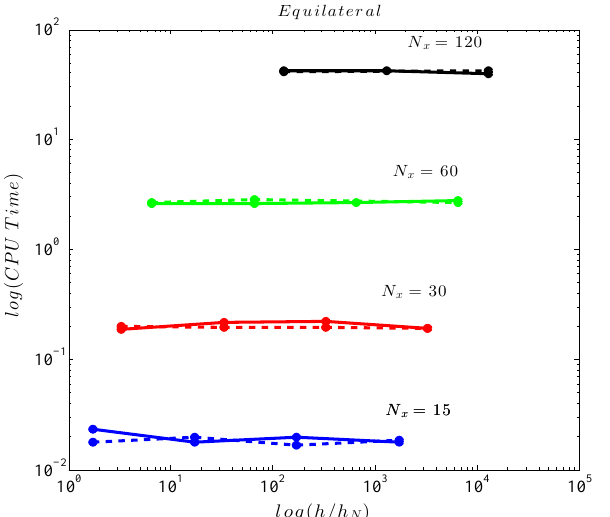
Figure 7. CPU time versus h / h N for GMRES (solid line) and BiCGStab (dashed line) using the ILU( k ) preconditioner with k = 300.